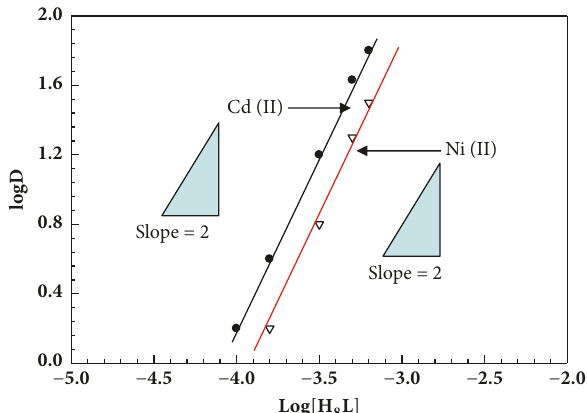
Figure 4: Plot of logD vs. log[H n L] for Cd 2+ and Ni 3+ under the same reaction condition of Figure 3.